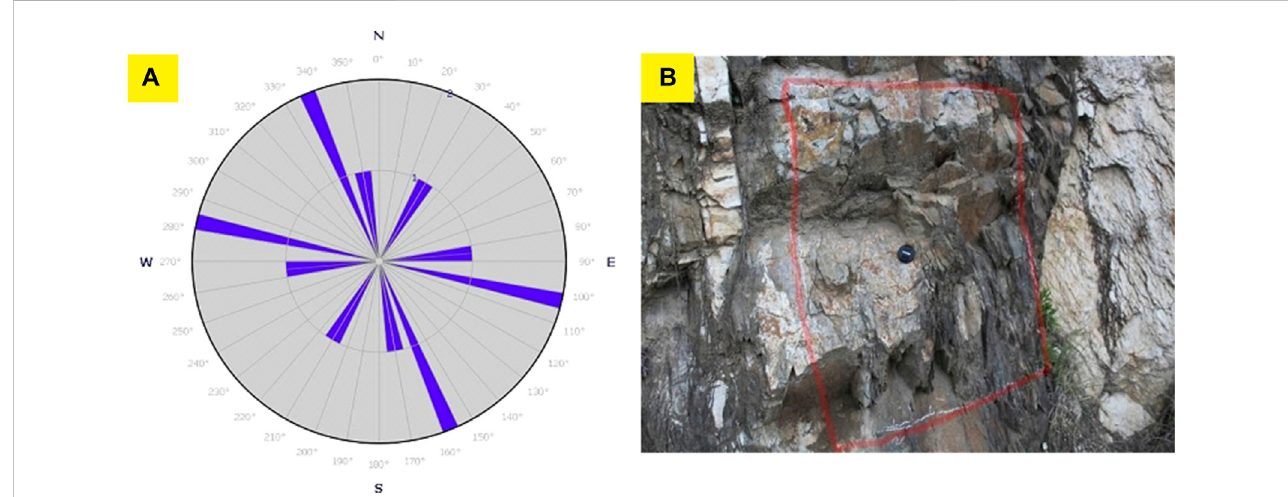
FIGURE 4 (A) Rose diagram showing the orientation of joints and (B) medium joint density rocks.